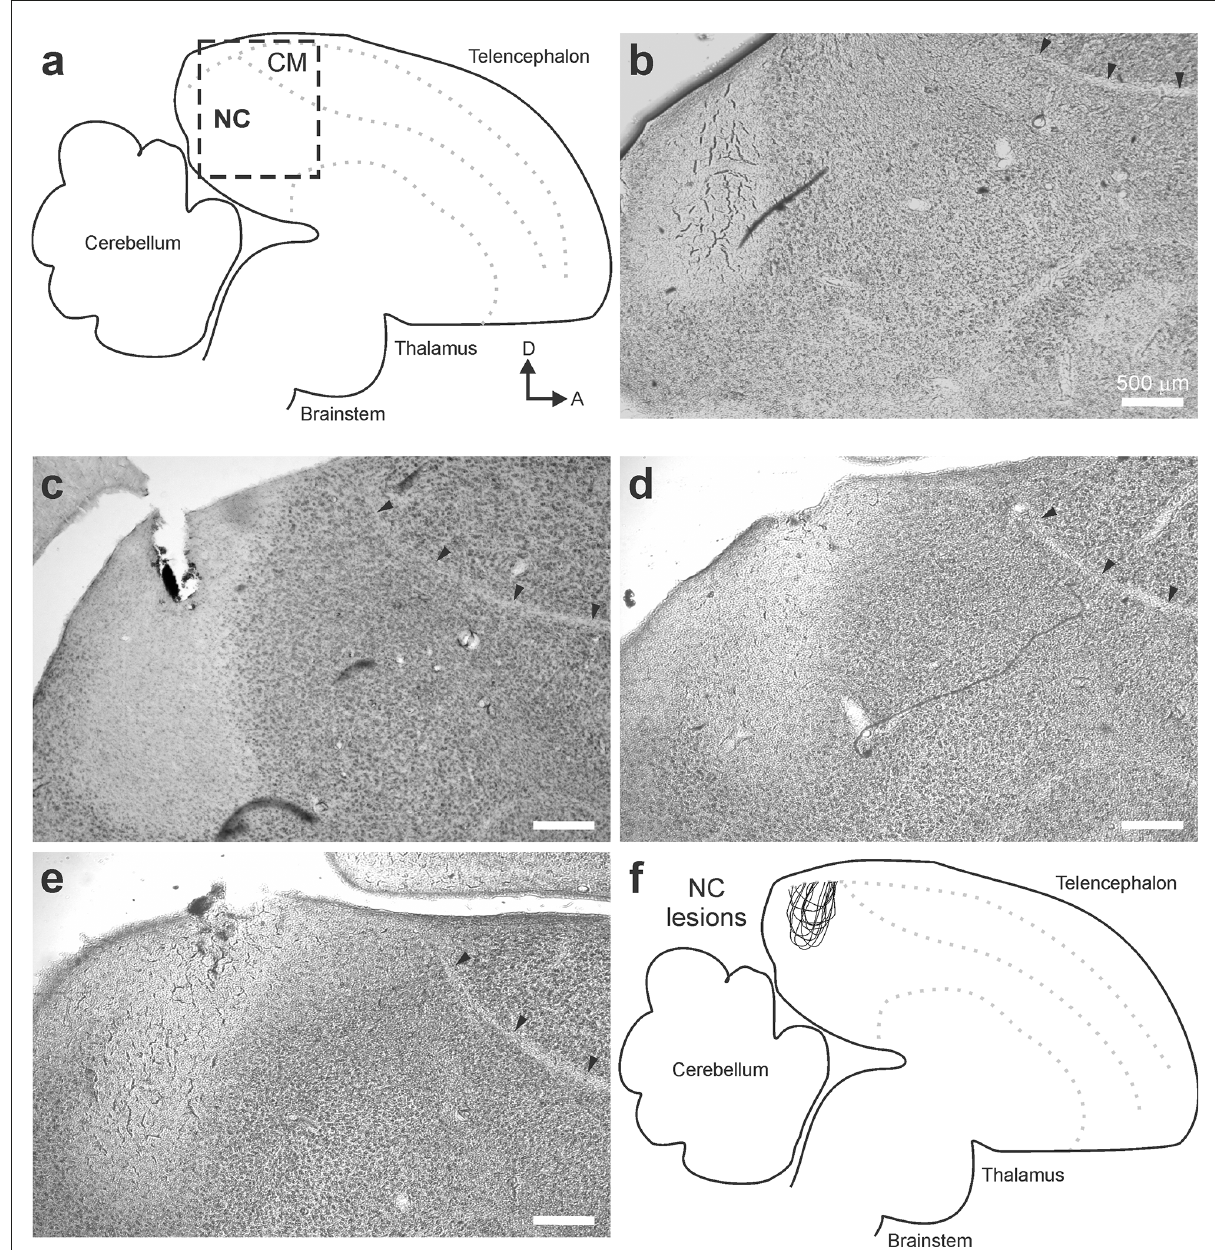
FIGURE2 Lesions were restricted to NC. (A) The location of NC was recognized by its relative position in the brain as well as lamina that serve as anatomical landmarks. (B–E) At the end of each experiment, brain tissue was collected and used to verify the location of each lesion in each hemisphere. In no case did lesions affect tissue anterior of the lamina mesopallialis (small arrows; an easily recognizable interface between NC and CM) or inferior of the dorsal arcopallium lamina (not shown; another easily recognizable interface between the nidopallium and the arcopallium). (F) An overlay of traces of individual lesion sites confirmed that all lesions were restricted to